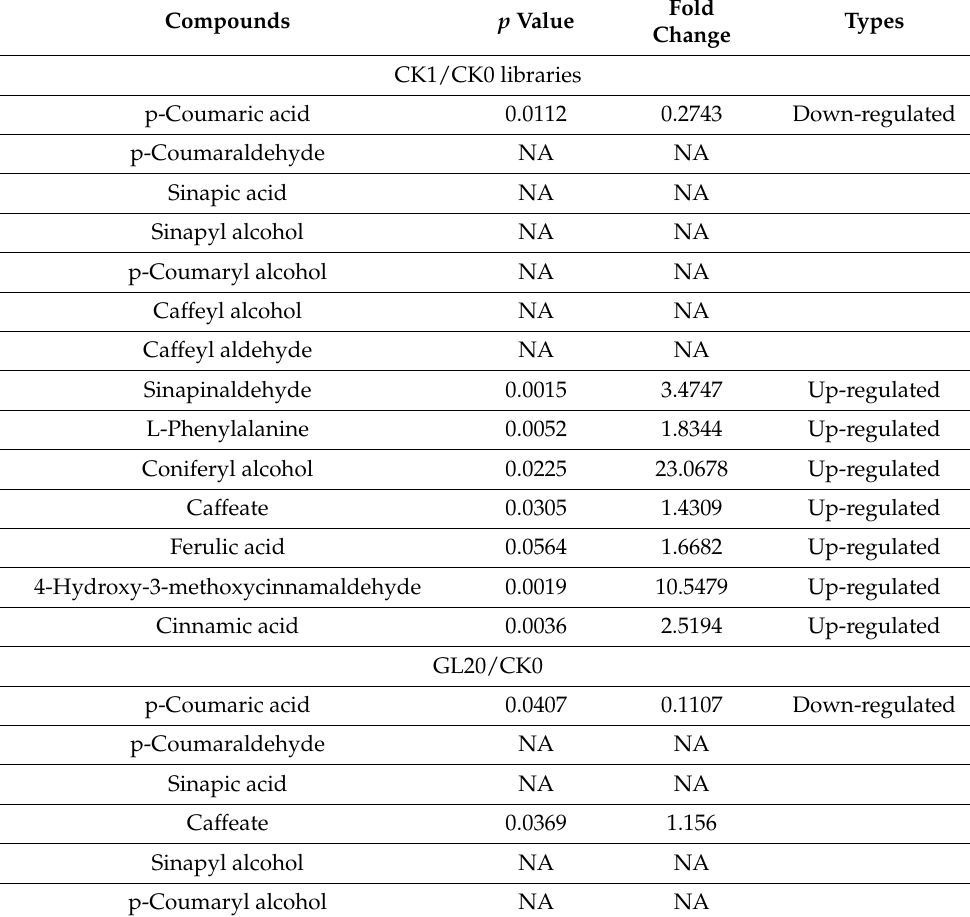
Table 1. Analysis of the metabolism of monomer lignin in lotus seedlings treated with 20 g/L and 50 g/L sucrose (NA means that the metabolites are too little to be determined; “——–” represents no difference between two